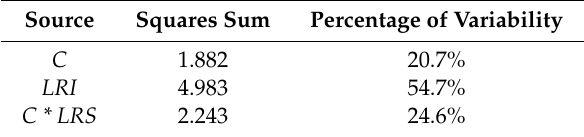
Table 6. Mg-Al-Mg test. Percentage of variability of each factor on Ln Ra according to ANOVA. Source Squares